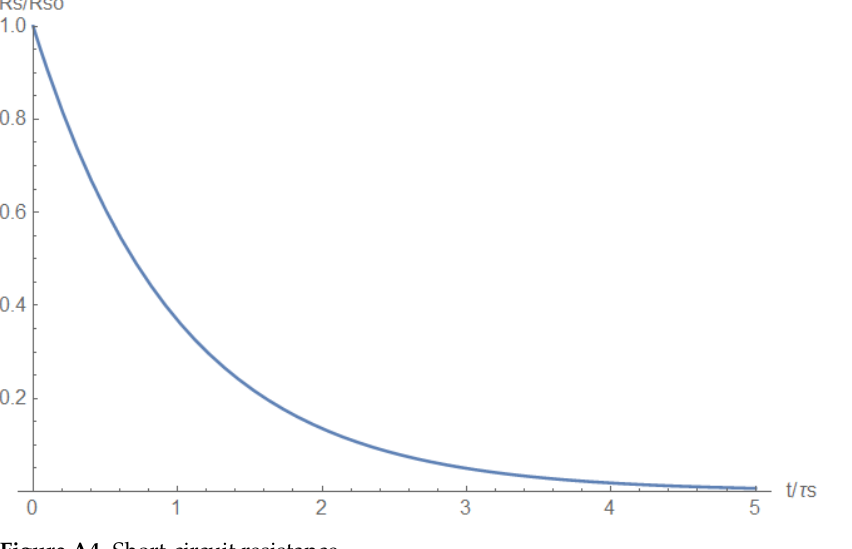
Figure A4. Short-circuit resistance. The transmission line resistances and the load impedance are described in Table